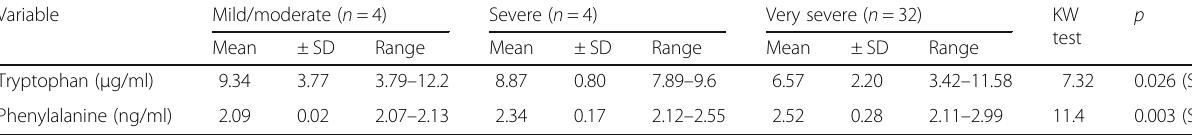
Table 3 Amino acids levels according to severity of depression among the treated group Variable